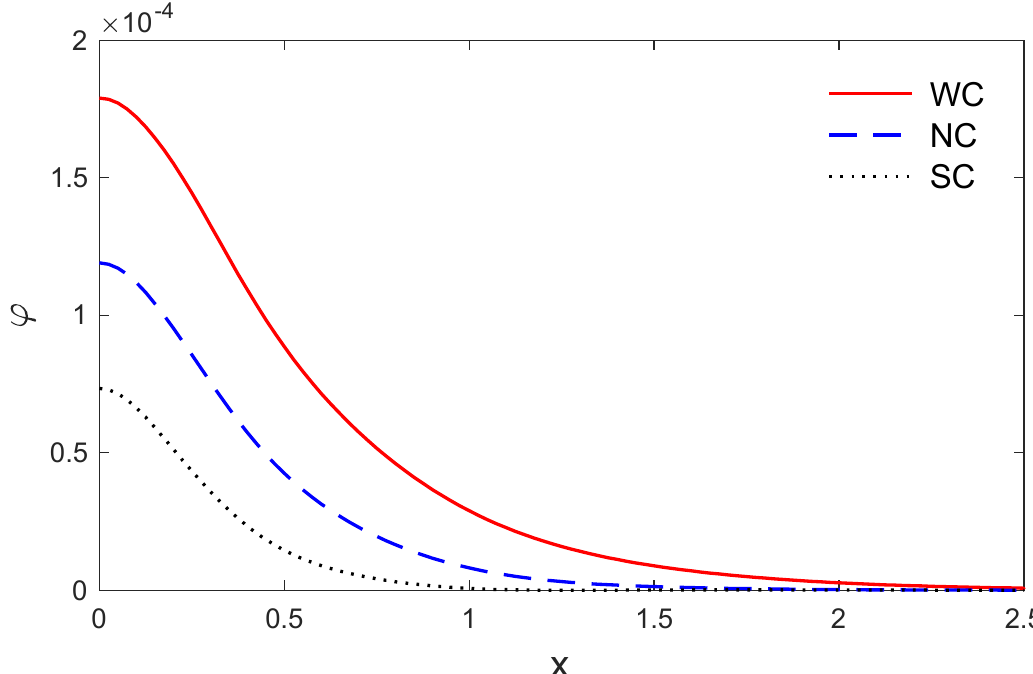
Figure 1. The change in volume fraction field of void variations ϕ via x and y = 0.4 for strong normal and weak conductivities.